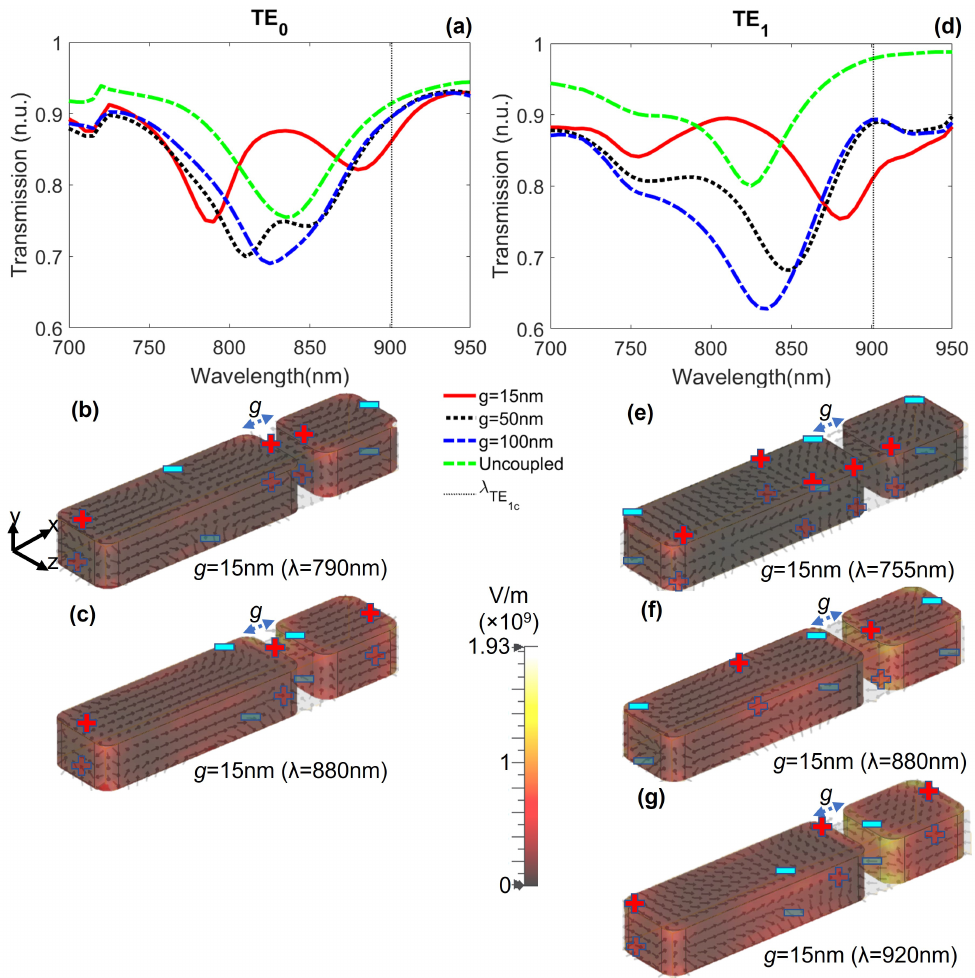
Figure 5. Transmission spectra with a dimer of gaps g = 15,50,100 nm. ( a ) For the TE 0 mode, the EIT-like effect is observed around λ = 835 nm (red continuous curve). As the gap g increases, the transparency window tends to disappear. ( b , c ) Electric field lines on the NPs for TE 0 mode. ( d ) For the TE 1 mode, the transparency effect is obtained around λ = 810 nm (red continuous curve) due to strong coupling of the NPs. The wider the gap, the weaker the transparency effect. ( e – g ) Electric field lines on the NPs for TE 1